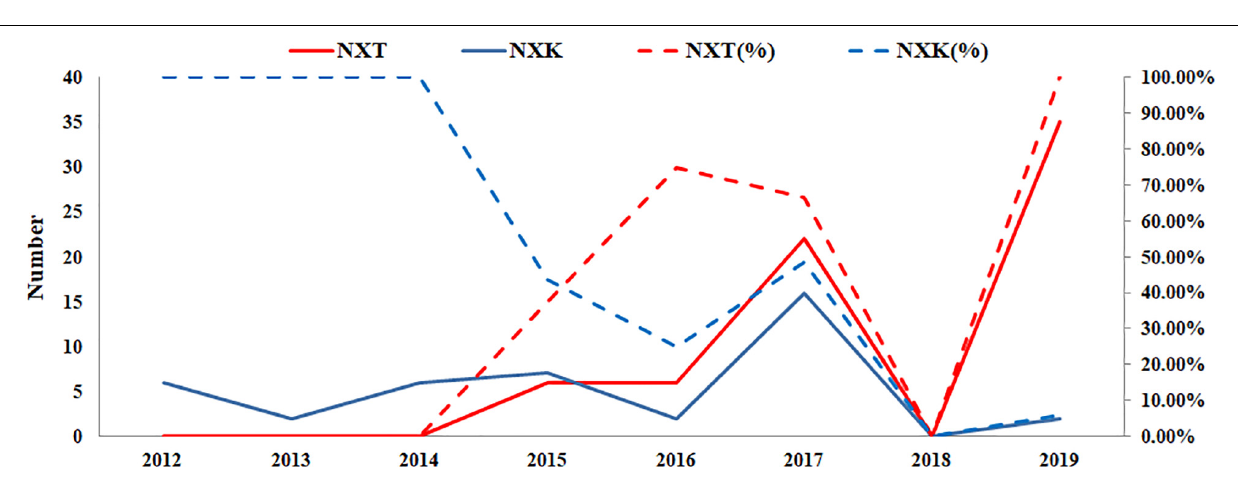
FIGURE 6 | Prevalence of the N-X-T/K motif in Guangdong, China from 2012 to 2019. The sequences of 106 clinical strains in Guangdong, China from 2012 to 2019 were collected from GISAID. The substitutes N-X-T/K at position 158–160 were analyzed. The y-axis on the left: the number of the substitutes N-X-T and N-X-K at HA1 residues 158–160; The y-axis on the right: the percentage of the substitutes N-X-T and N-X-K at HA1 residues